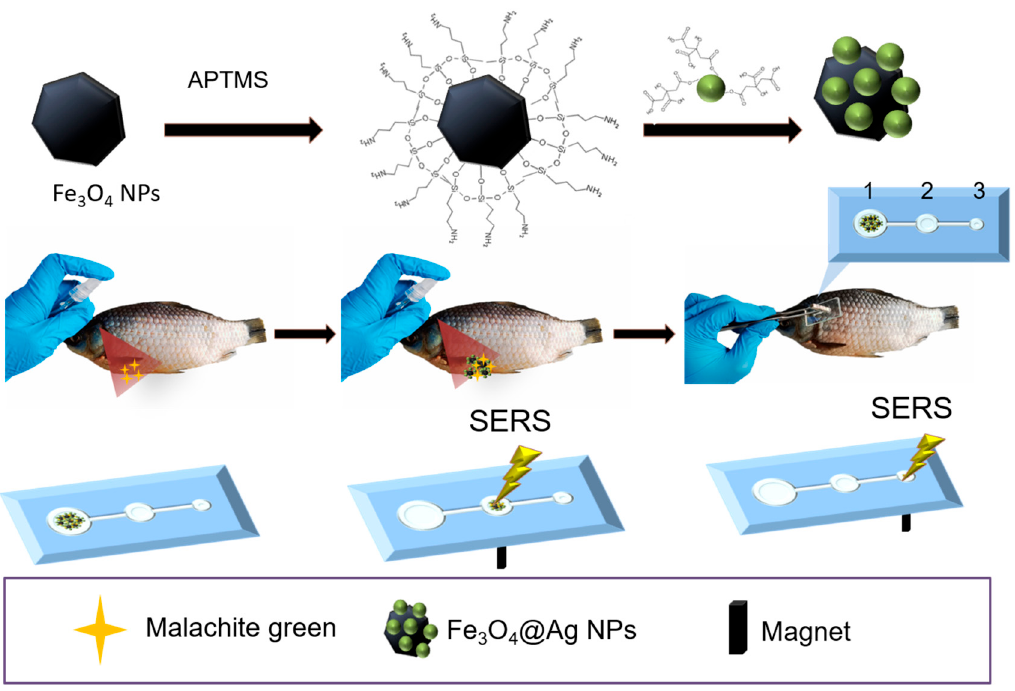
Scheme 1. Schematic illustration of the synthesized magnetic–plasmonic composite and its